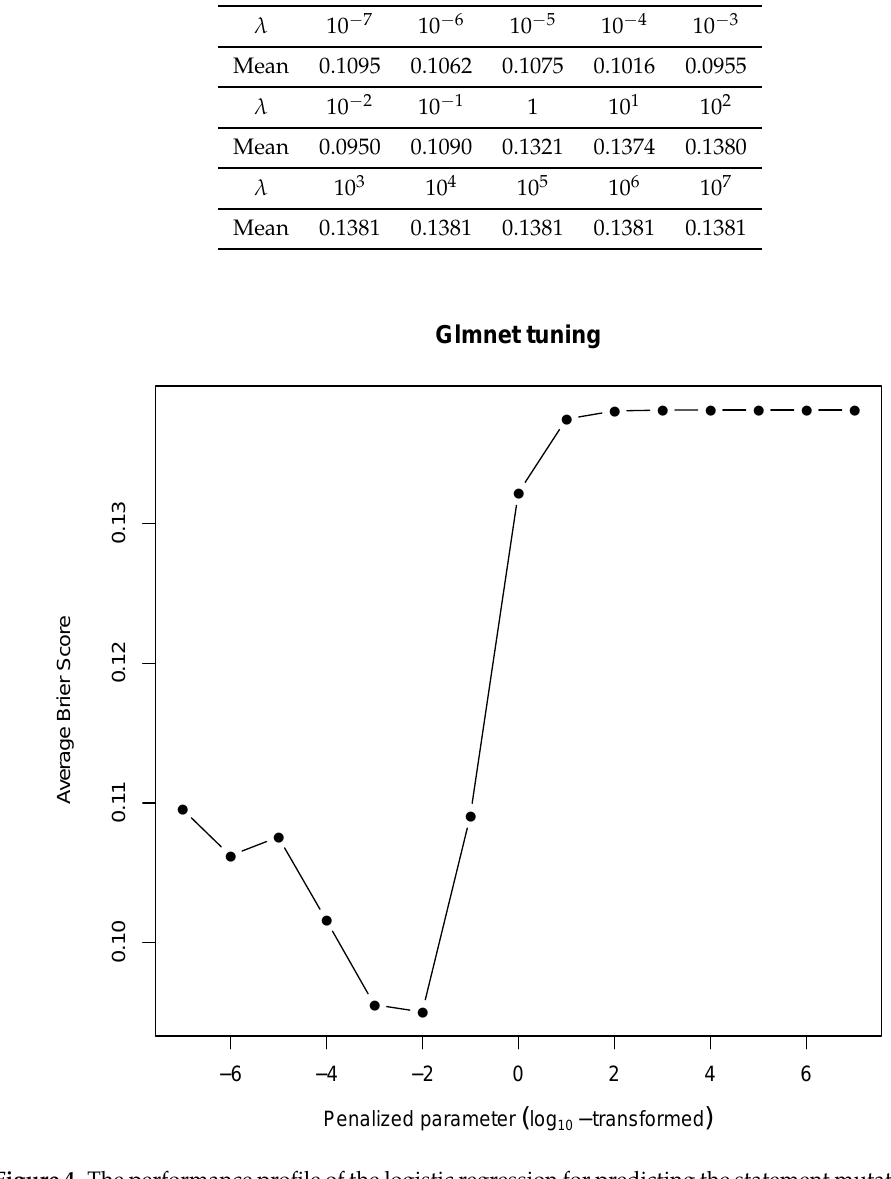
Figure 4. The performance profile of the logistic regression for predicting the statement mutation